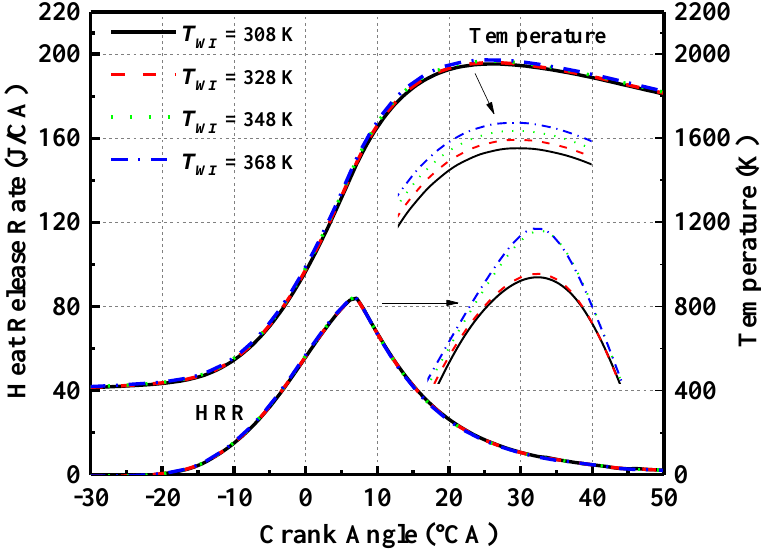
Figure 18. Effects of 𝑇 𝑊𝐼 on HRR and in-cylinder temperature (GDI; 𝑅 𝑤𝑓 = 1.0).